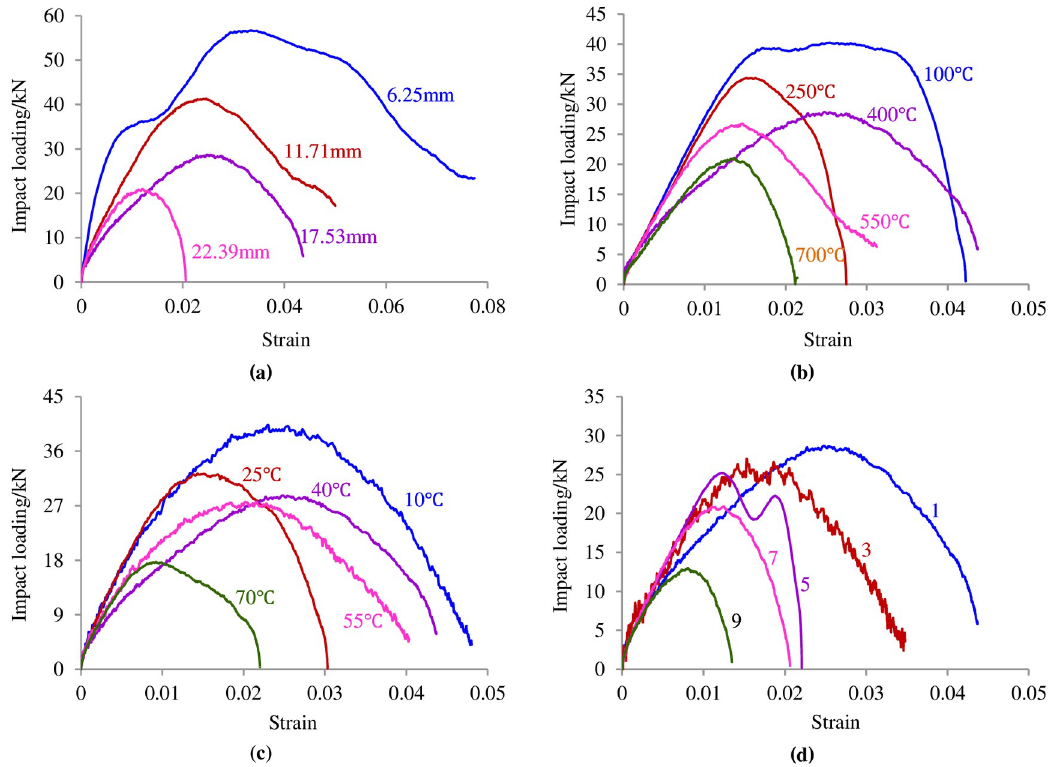
Fig 4. Impact load-displacement curves of circular granite samples under the condition of the heat treatment and water curing. (a) Load-strain curves of circular rock samples with different inner diameters (The figures in the figure represent the inner diameter of the circular granite specimens). (b) Load-strain curves of circular rock samples under different high temperatures (The figures in the figure represent the heat treatment temperature). (c) Load-strain curves of circular rock samples different curing temperatures (The figures in the figure represent the curing water temperature). (d) Load-strain curves of circular rock samples with different times of heating (The figures in the figure represent the number of cyclic